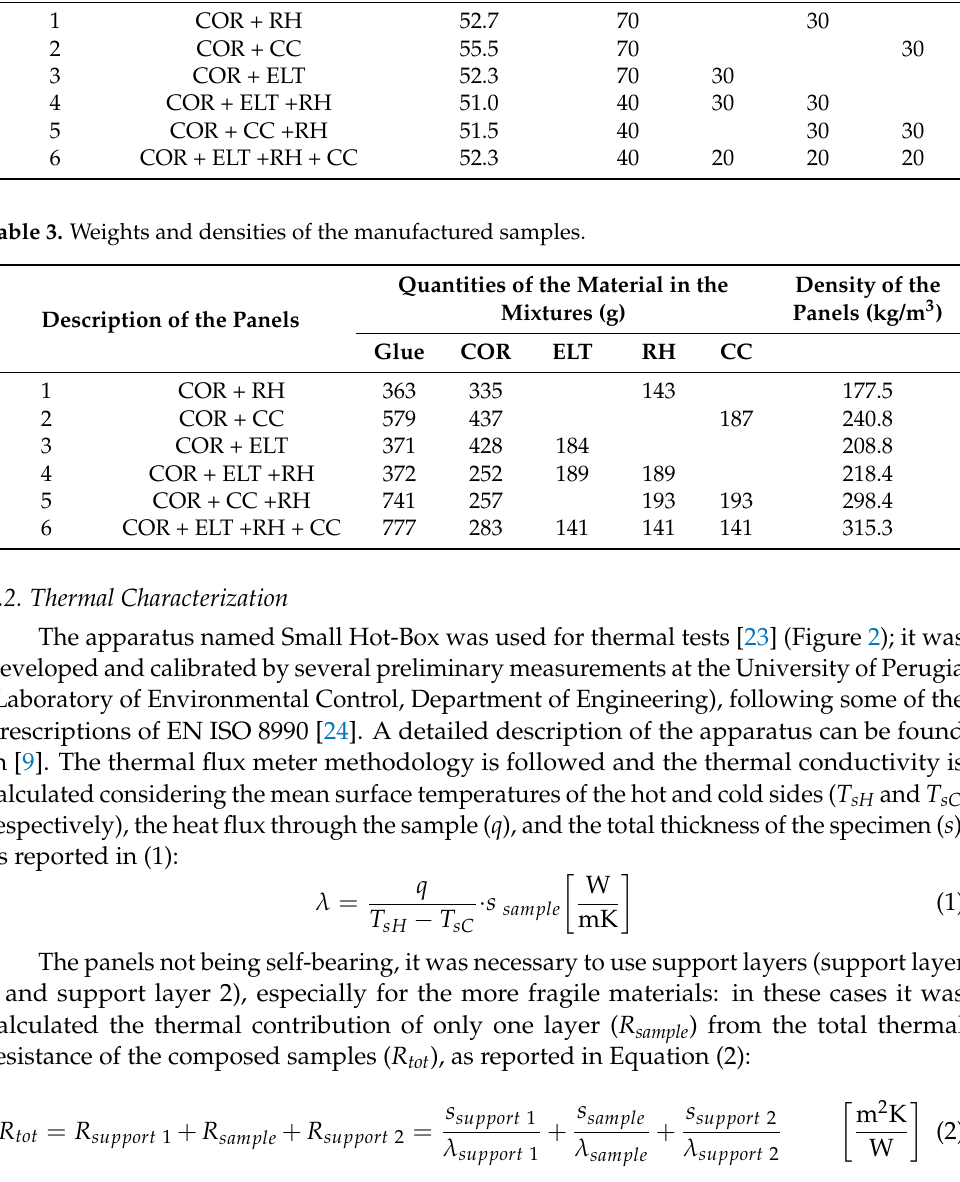
Table 2. Weight ratio of the manufactured samples.